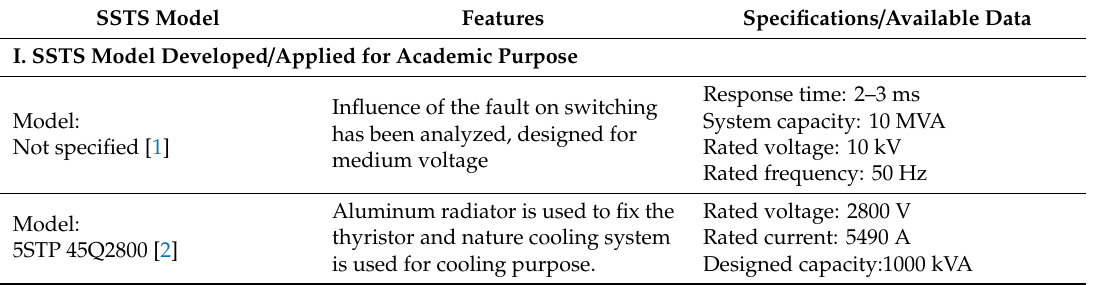
Table 3. Specifications of various SSTS